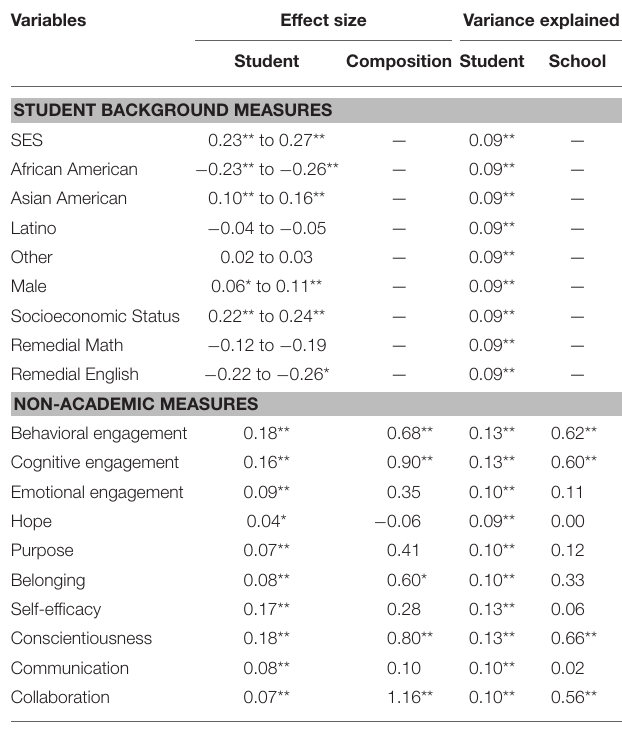
TABLE 4 | Student and peer composition effects on academic performance, no control covariates. Variables